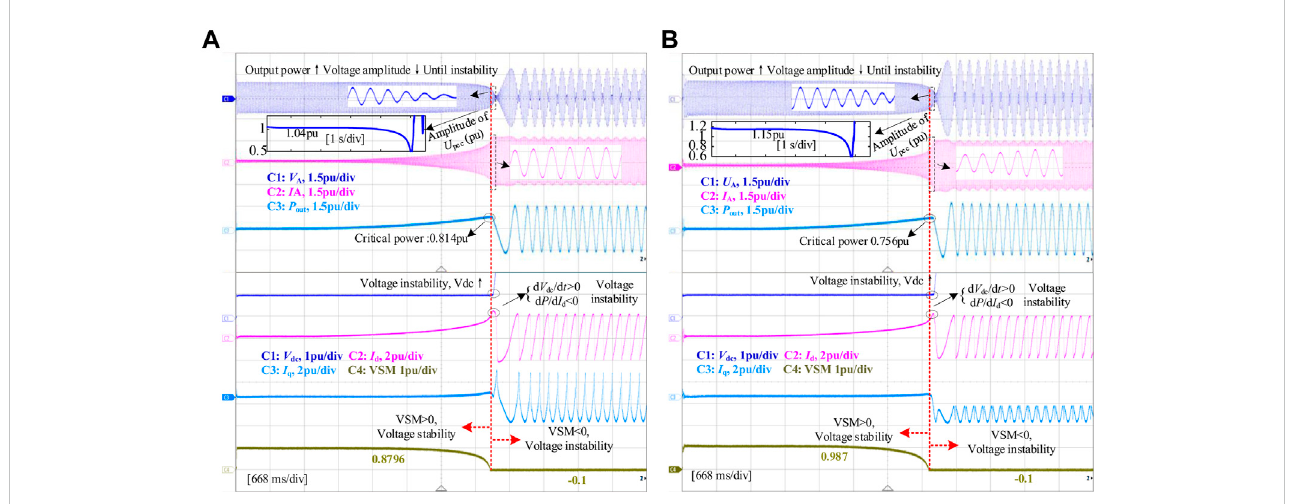
FIGURE 13 Comparison ofVSMunderdifferentgridimpedances. (A) R L =0.0108 Ω /km, L L =0.382e-3H/km, C L =0.204 – 7F/km, (B) R L =0.0108 Ω /km, L L =0.382e- 2H/km, C L = 0.204 – 6F/km.